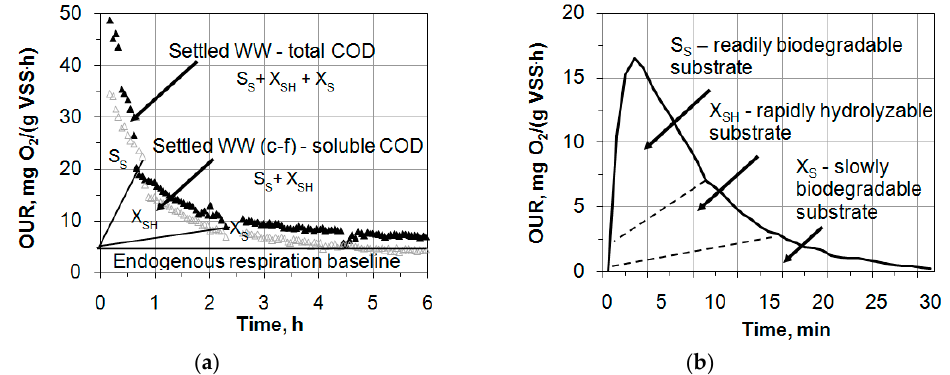
Figure 3. Sample results of measured date and model predictions from ( a ) Gdansk WWTP—long-term OUR (oxygen uptake rate) batch tests ( b ) Malaga—short-term OUR batch tests